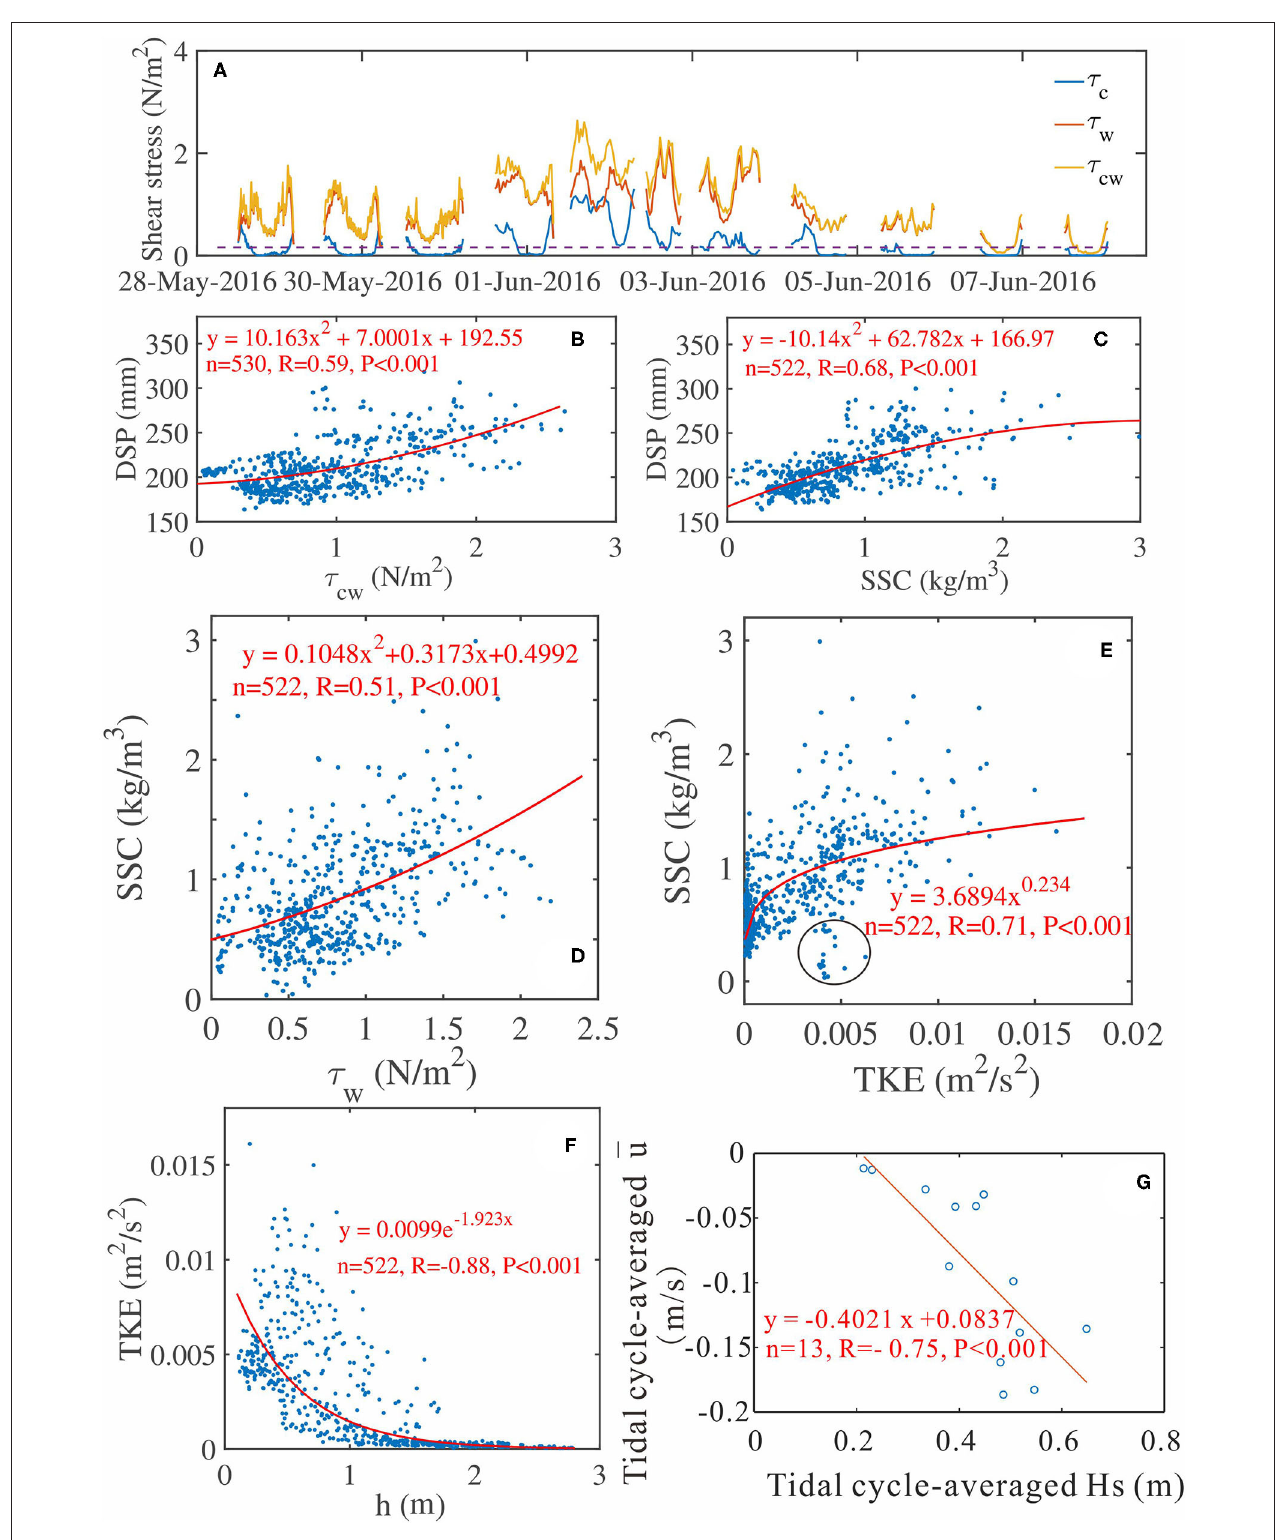
FIGURE 8 | (A) Variations of bed shear stress induced by combined wave and current ( τ cw , yellow line), induced by wave ( τ w , red line), and induced by current ( τ c , blue line), respectively. The horizontal dashed line indicated the critical bed shear stress (0.16 N/m 2 ); (B) DSP against bed shear stress induced by wave ( τ w ) from